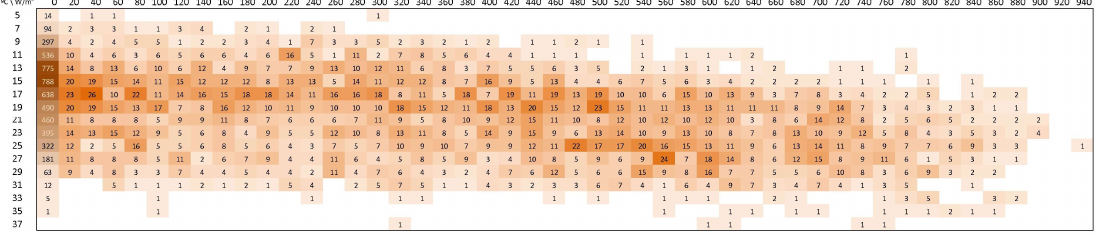
Figure 6. Frequency matrix for PTC in Almeria: modified DNI-temperature.